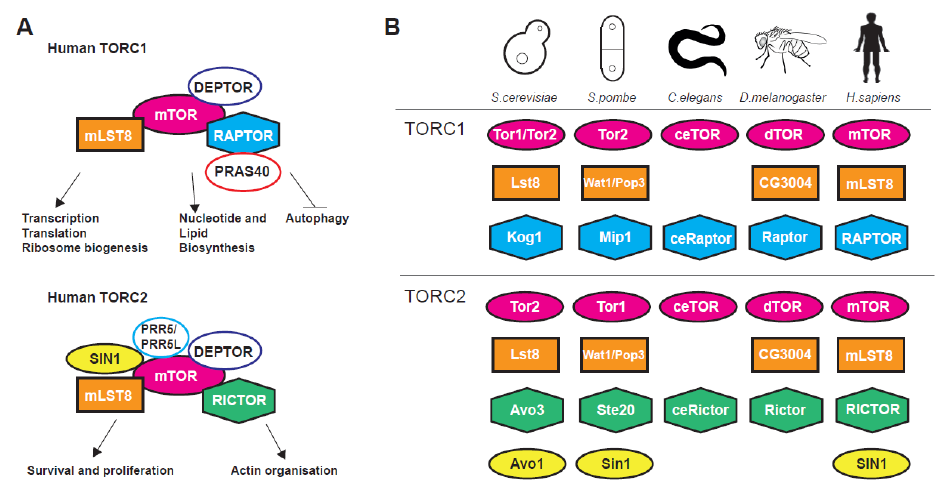
Figure 1. ( A ) TORC1 and TORC2 subunits and processes controlled by the complexes. ( B ) Target Of Rapamycin Complexes (TORC1 and TORC2) subunits in various model organisms used in ageing research.